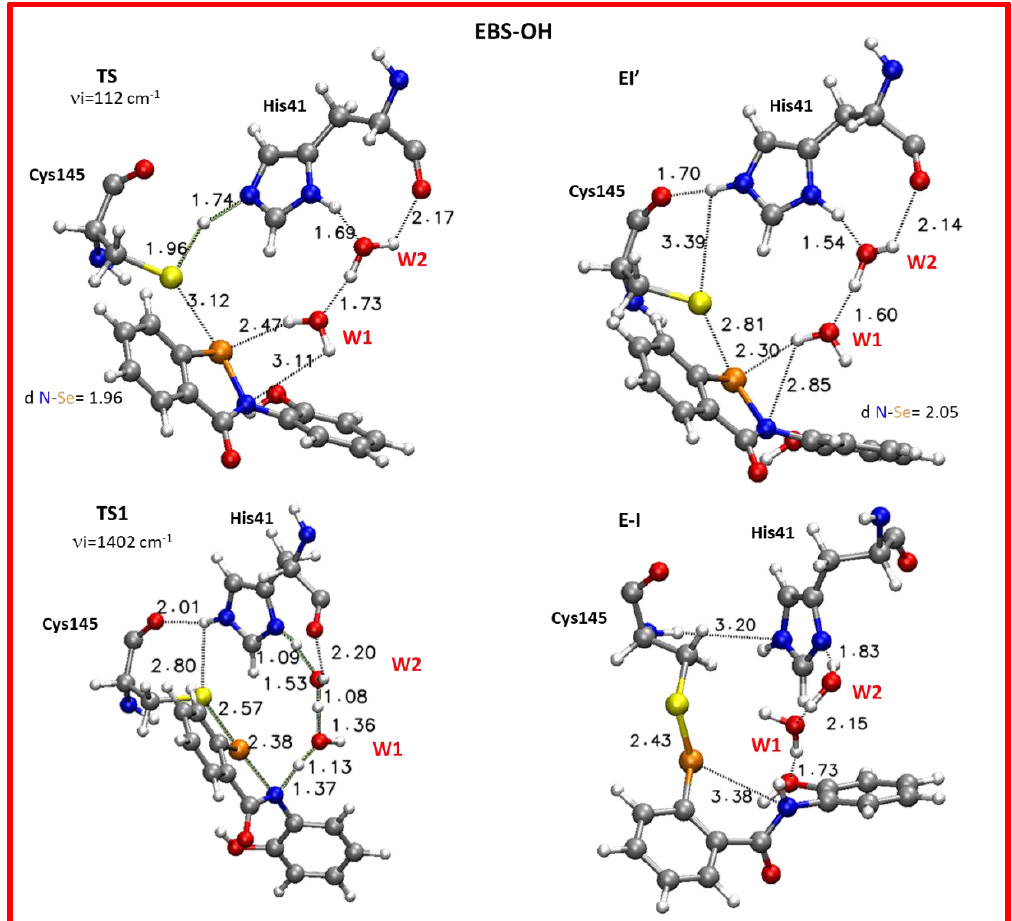
Figure 8. Optimized structures of the stationary points involved in the M pro -HID inhibition process promoted by EBS-OH. For clarity, only residues of the model implicated in the chemical event are shown. Main distances are in Å. Imaginary frequencies are reported in cm-1 for all transition states. Cartesian coordinates of the optimized structures with the full model for these transition states as well as for the intermediates along the reaction pathway are given in the Supplementary Materials.